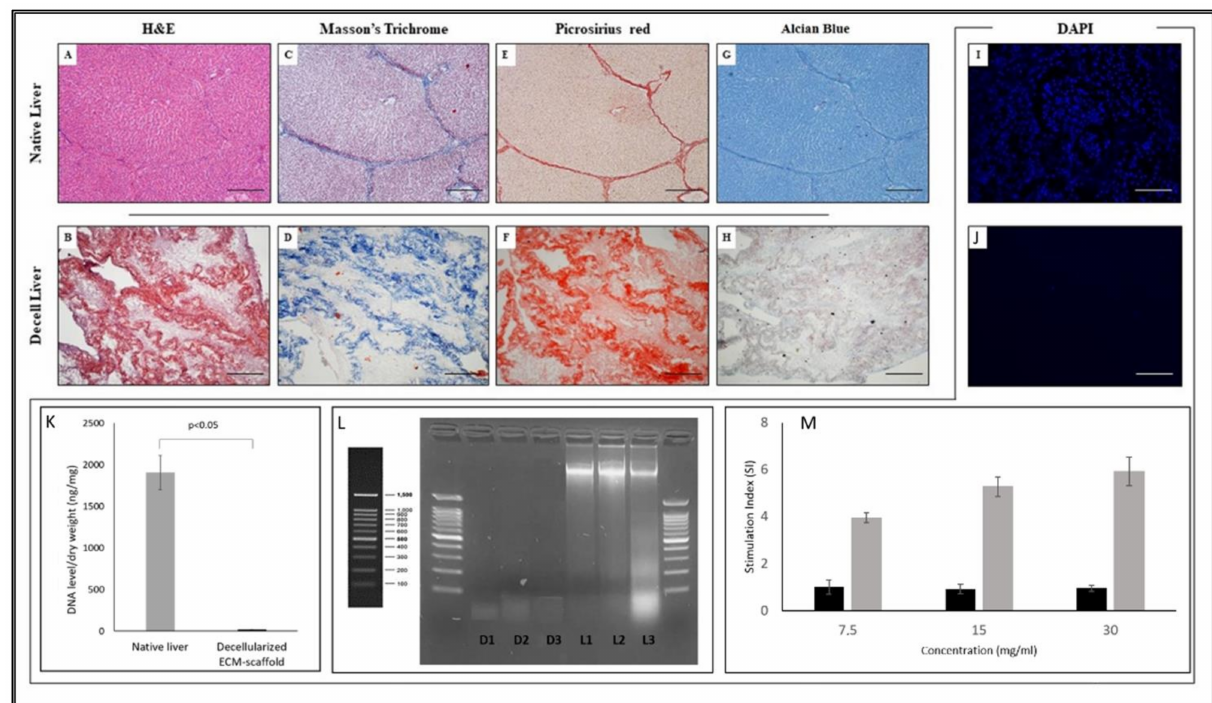
Figure 2. Structural characterisation of porcine liver scaffolds. Panel A – J . Histological and DAPI staining of native liver and decellularised ECM scaffold. Histological staining revealed the preser- vation of the ECM structures. In particular, Haematoxylin/Eosin (H&E) ( A , B ), Masson’s Trichrome ( C , D ) Picrosirius Red ( E , F ), and Alcian Blue ( G , H ) (magnification 4 × ). DAPI ( I , J ) confirmed the absence of nuclei and residual nuclear material (magnification 10 × ). Scale bar: 200 µ m for each. Panel ( K ). DNA level in native and decellularised scaffolds. Values represent mean ± SE of five samples for each group ( p < 0.05; n = 5). Panel ( L ). DNA Electrophoresis. Fragments were detected by staining the agarose gel with SYBR Green, followed by visualisation/photography under UV light. In order to quantify the different DNA fragment bp sizes, a DNA ladder was inserted for scaling purposes. DNA Electrophoresis on three ECM samples (D1, D2 and D3) showed residual DNA fragments smaller than 100 bp. Panel ( M ). Native liver and decellularised ECM immunogenicity in vitro evaluation. No immunogenic effect was observed at the three different concentrations for decellularised ECM. As a positive control, lyophilised native liver was used at the same concentrations. Results are reported as SI. Values represent the mean ± SD of five replicates. Black bars: lyophilised decellularised ECM; grey bars: lyophilised native